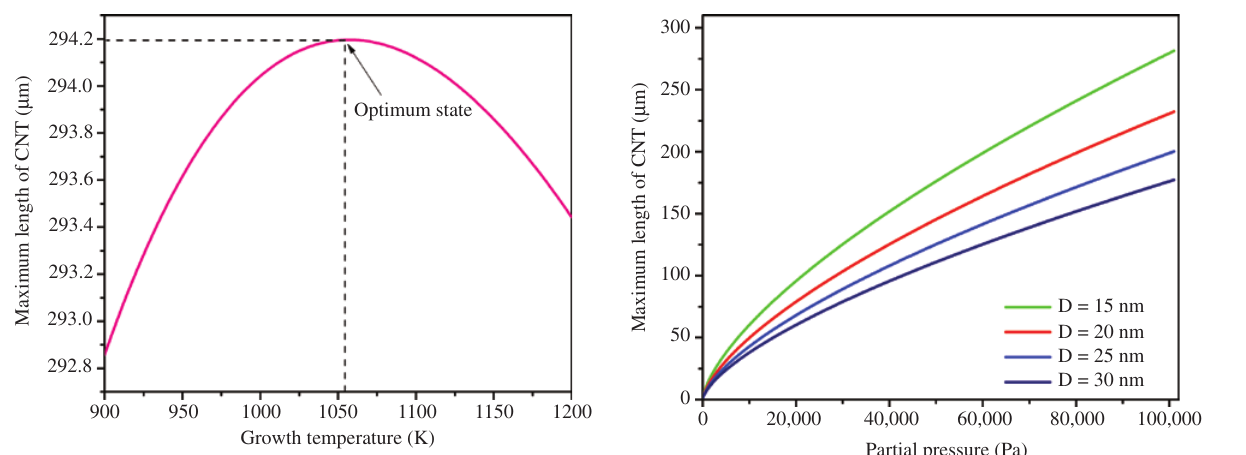
Figure 6: Effect of partial pressure of decomposed feedstock gas on the length of the grown CNT on GS with different